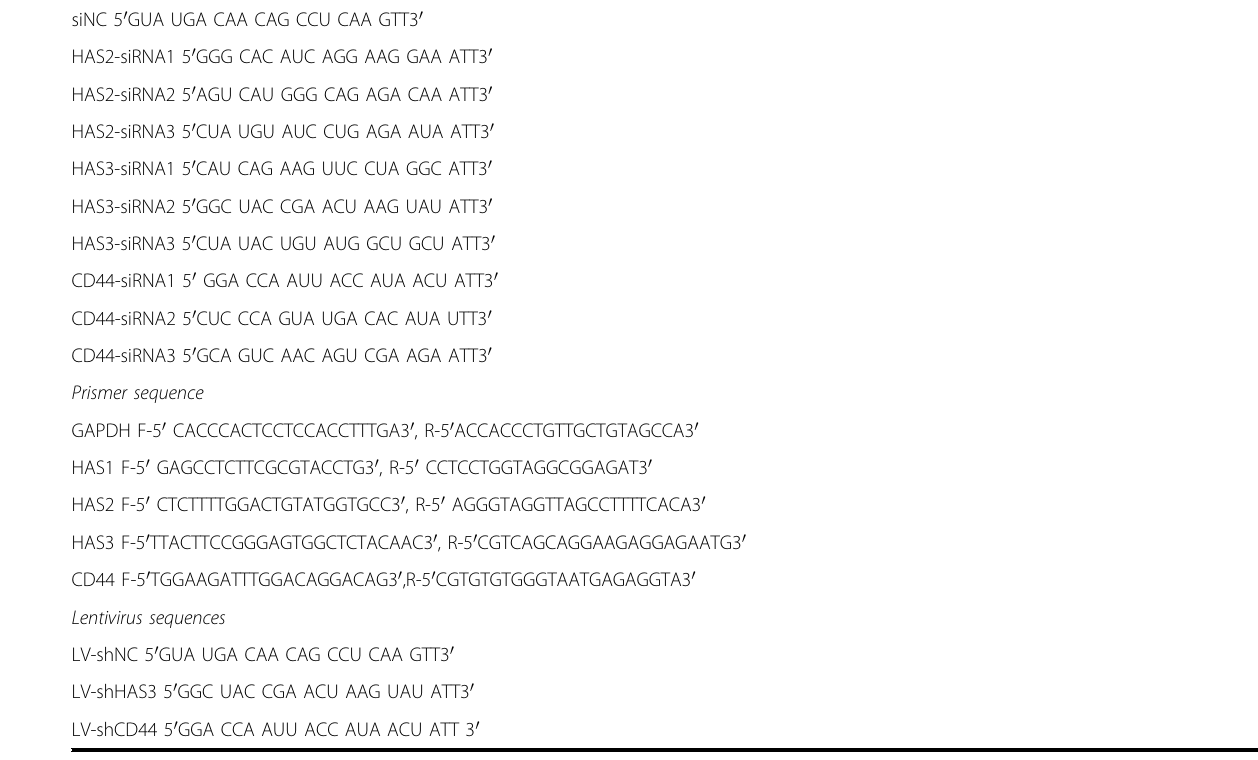
Table. 1 Sequence of siRNA, prismer and lentivirus. siRNA